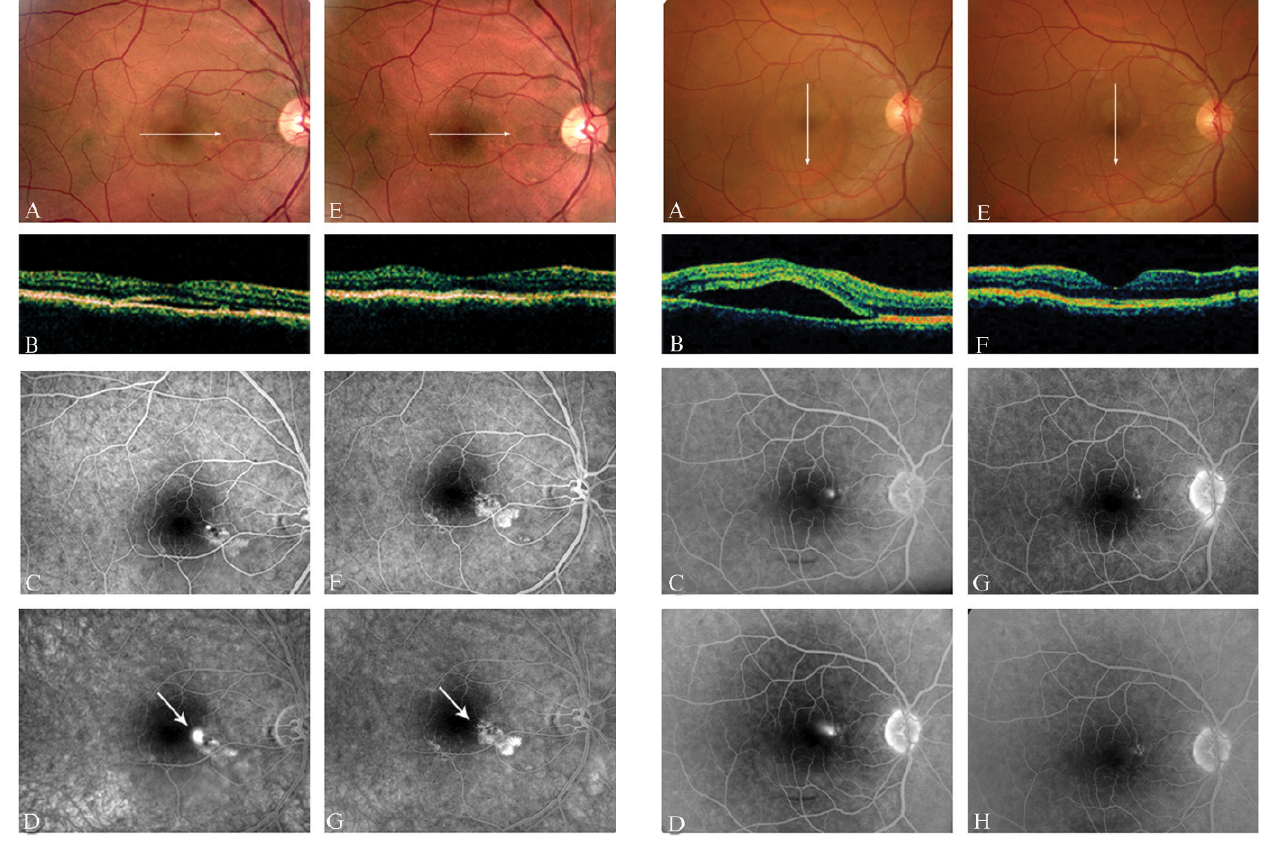
Figure 4 - A patient with a three-month history of recurrent CSC. Fundoscopy and OCT revealed serous detachment in the macular area (A-B). Fluorescein angiography showed a parafoveal leak in the papillomacular bundle (C-D). The serous detachment and the leak were both resolved after anti-HP